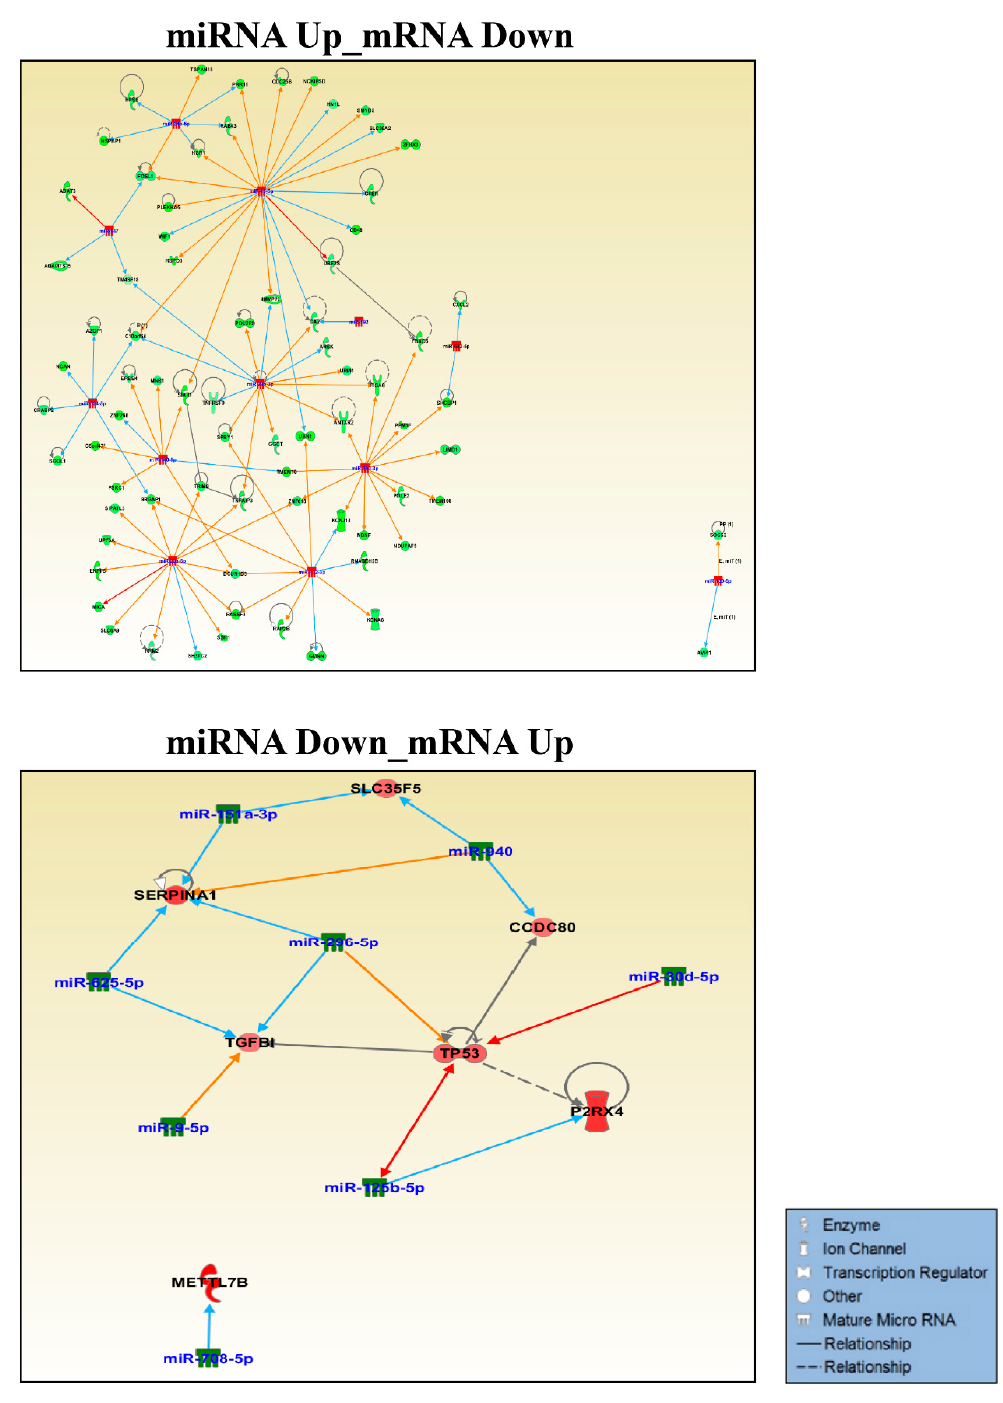
Figure 3. Molecular networks of anti-correlated miRNA-mRNA pairs in H1299 / mutant p53 R273H cells derived from the integrated miRNA-mRNA expression analysis. Target genes of the up-regulated miRNAs (Red) were down-regulated (Green) [upper panel] and those of down-regulated miRNAs (Green) were up-regulated (Red) [lower panel] in the presence of mutant p53 R273H . The color intensity of the nodes indicates relative miRNA or mRNA expression levels in presence of mutant p53 R273H . The types of interaction between miRNAs and their respective target mRNAs are represented by arrows in dark red (experimentally validated), bright orange (highly predicted), and light blue (moderately